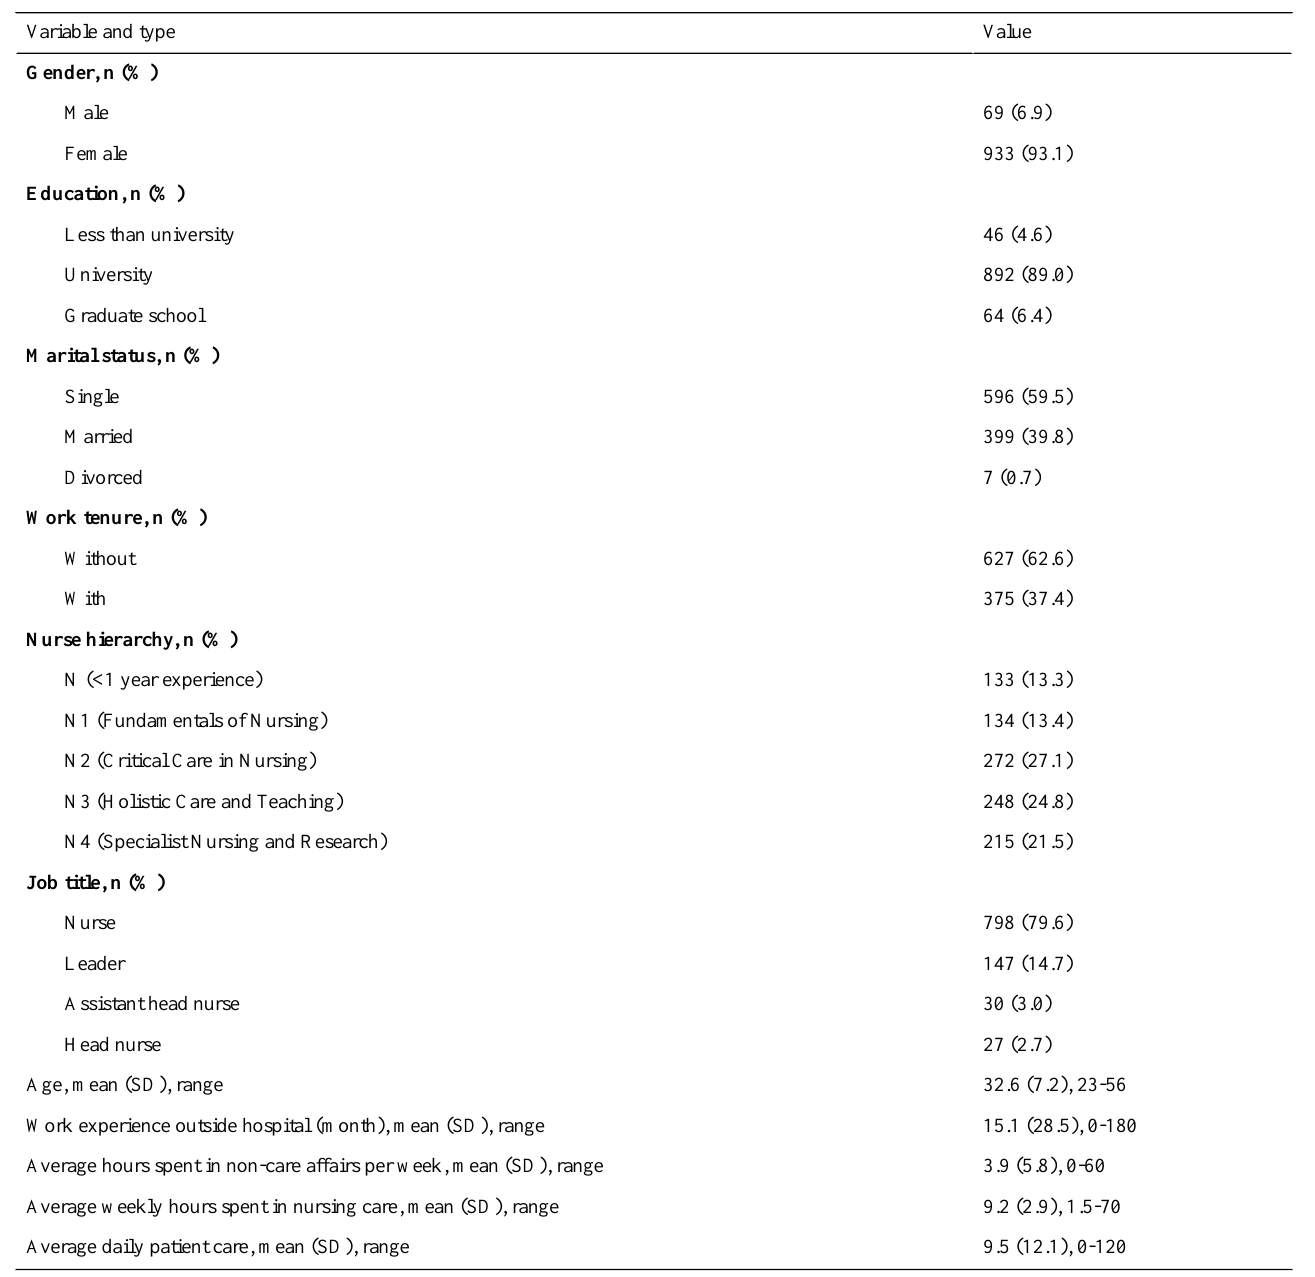
Table 1. Demographic data of the study